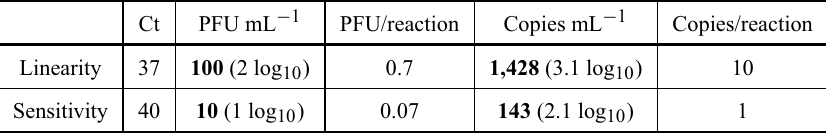
Limit of detection of YFV 17DD virus RNA by real-time